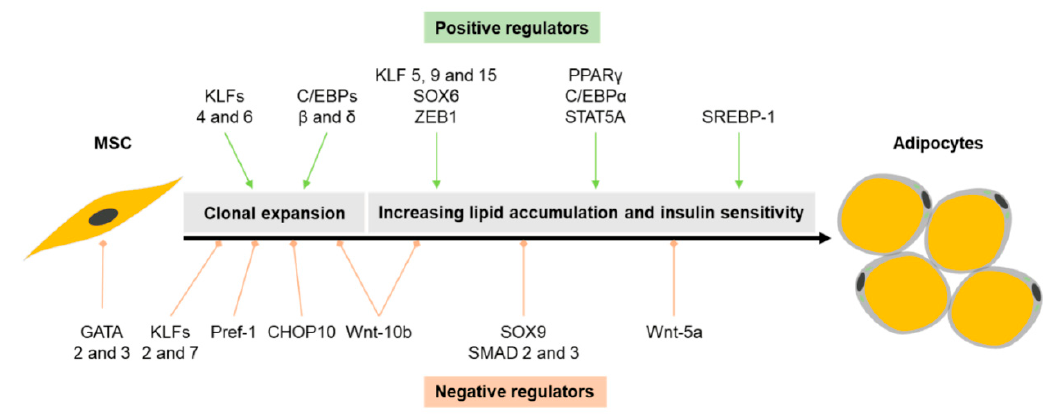
Figure 4. Positive and negative regulators of white adipogenesis. Adipogenesis is tightly regulated by several transcription factors that are expressed at di ff erent stages during the di ff erentiation pathway. Image adapted (with permission) by C.d.S., K.K. and M.A. from Sarjeant and Stephens et al. (2012) [12]. MSC, Mesenchymal stromal / stem cell; AP-1, activating protein-1; KLFs, Krüppel-like factors; C / EBP, CAAT-enhancer binding proteins; PPAR γ , Peroxisome proliferator-activated receptor gamma; STAT, Signal transducer and activator of transcription; SREBP-1, sterol regulatory element binding protein 1; Pref-1, preadipocyte factor 1; Wnt, Wingless / Integrated protein; SOX 6 and 9; Sex-Determining Region Y-Box 6 and 9; SMAD 2 and 3, Mothers against decapentaplegic homolog 2 and 3; CHOP10, C / EBP homologous protein 10; ZEB1, Zinc finger E-box-binding homeobox 1.